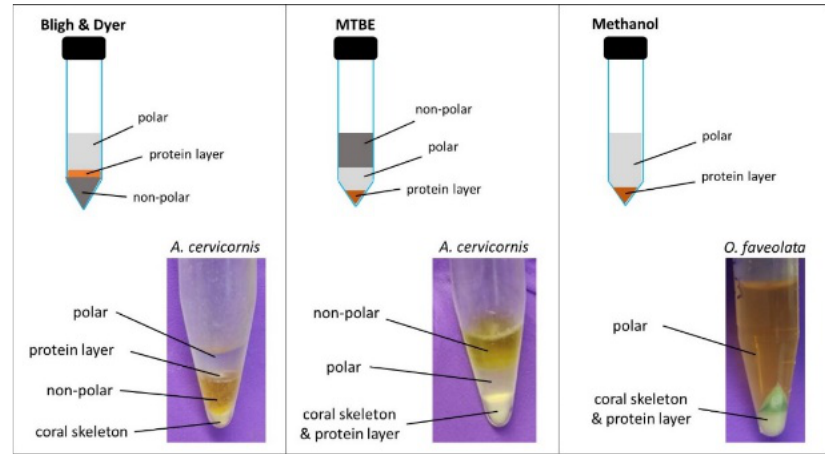
Figure 1. Diagram of solvent systems from three extraction methods: Bligh and Dyer, methyl tert -butyl ether (MTBE), and methanol extraction. A. cervicornis = Acropora cervicornis; O. faveolata = Orbicella faveolata .